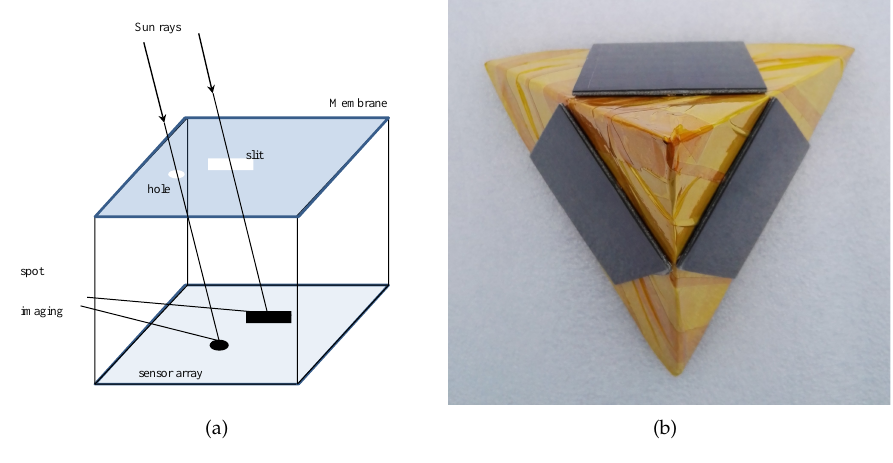
Figure 1. The structure of sun sensors. ( a ) The planar array. ( b ) The triangular pyramidal